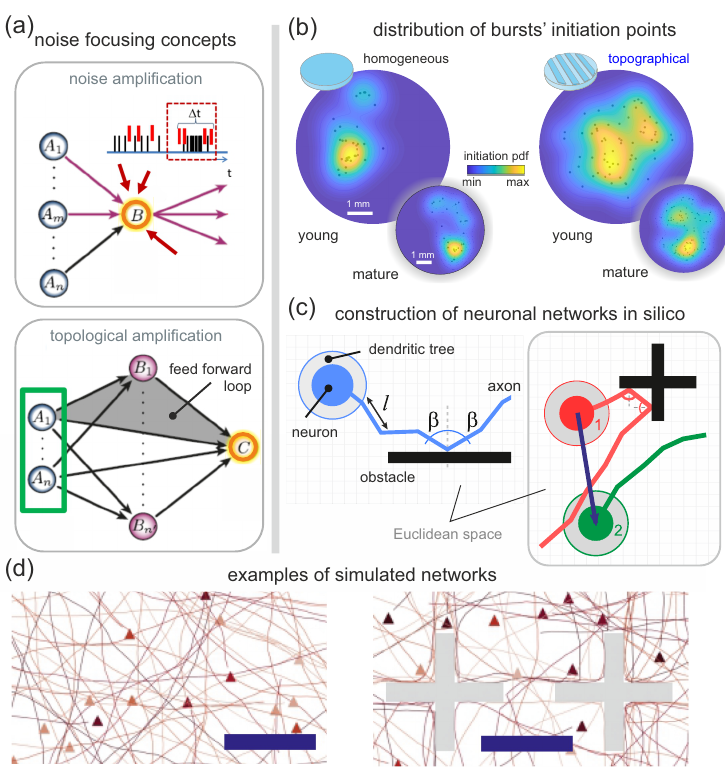
Figure 5. Noise focusing’ concept and numerical simulations. ( a ) sketch of the two major ingredients that shape noise focusing. Top, ‘noise amplification’ concept. Without noise, neuron B needs to receive a quorum of m 0 inputs (black arrows and upper vertical bars) in a time window ∆ t from { A } neurons to activate. Input noise (red arrows and bars) relaxes the quorum condition and 0 ,... A m the neuron B can effectively activate with fewer spikes from other neurons. Bottom, ‘topological amplification’, by which spikes elicited by neurons are amplified by network motifs such as feed forward loops (gray triangle). In the sketch, neurons A 1 and A n emit two spikes, which become amplified by the loops involving neurons B 1 and B n , effectively providing an input of four spikes to neuron C; ( b ) distribution of burst initiation in standard and topographical cultures, and comparing two developmental stages of the cultures. The black dots are the observed initiation points of network bursts, and the blue-yellow pattern is the corresponding probability distribution function (pdf) of burst initiation. The yellower a region of the culture is, the higher the probability of burst initiation is in that region; ( c ) in silico model of a neuron grown on a two-dimensional substrate. The neuronal soma and dendritic tree are simulated as discs, and the axon as concatenated segments of length (cid:96) . Interactions with obstacles are implemented as a simple rule by which an incident axon onto a surface is reflected with the same angle β . Connectivity is established whenever the axon of a neuron 1 crosses the dendritic tree of a neuron 2; ( d ) examples of positioned axons in the absence (left) and presence (right) of obstacles. Neurons are shown as triangles for clarity, with their color intensity proportional to their connectivity. Blue scale bars represent 100 µ